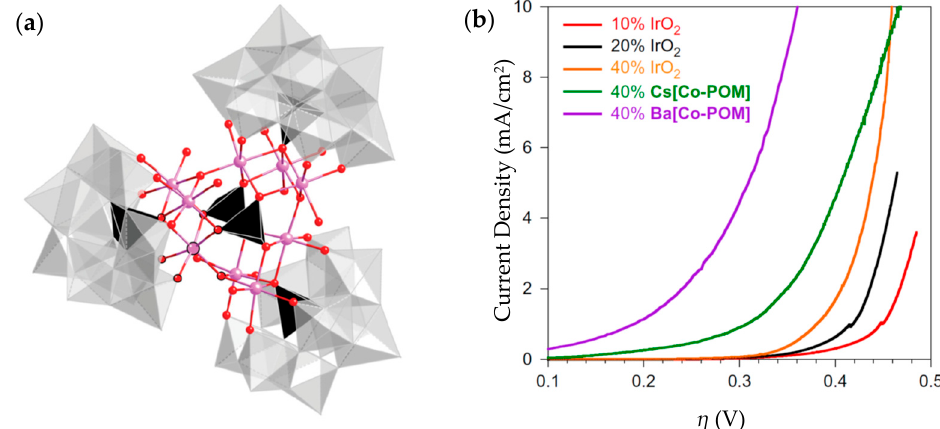
Figure 19. ( a ) Molecular structure of the Co ‐ POM cluster; ( b ) Linear sweep voltammetry of different Co ‐ POM electrocatalysts compared with different carbon paste/IrO 2 blends in 1 M H 2 SO 4 . Reprinted with permission from [212]. Copyright 2017 Nature Publishing Group, Macmillan Publishers Limited.